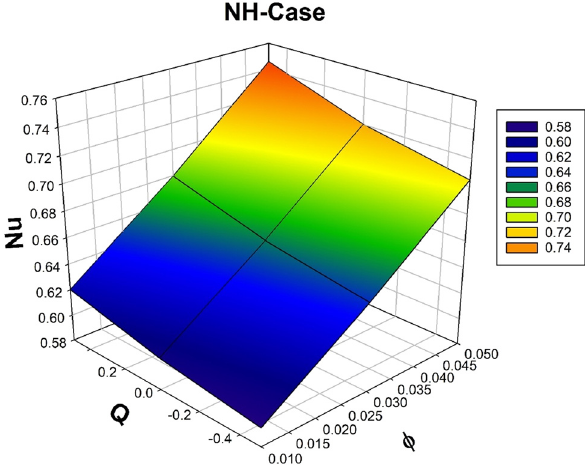
Figure 11: Change in − Cf against Ma for heightening of ϕ .